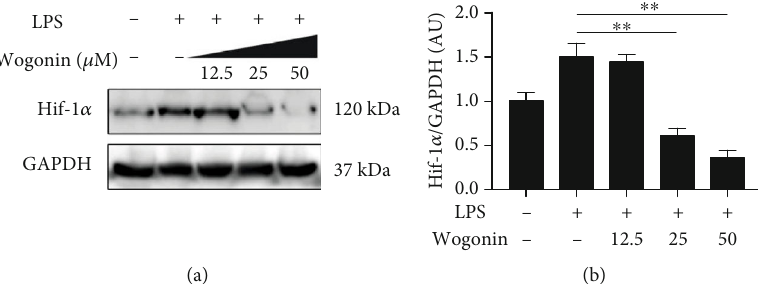
Figure 7: Wogonin decreased the Hif-1 α expression in LPS-treated B cells. Puri fi ed B cells were cultured with LPS for 6h in the presence of di ff erent concentrations of Wogonin (0, 12.5, 25, and 50 μ M). (a) Hif-1 α amount from LPS- and Wogonin-treated B cells was assessed by immunoblots; GAPDH was applied as loading control. (b) The quantitative grey intensity of Hif-1 α blots from three independent experiments was shown. ∗∗ P < 0 : 01